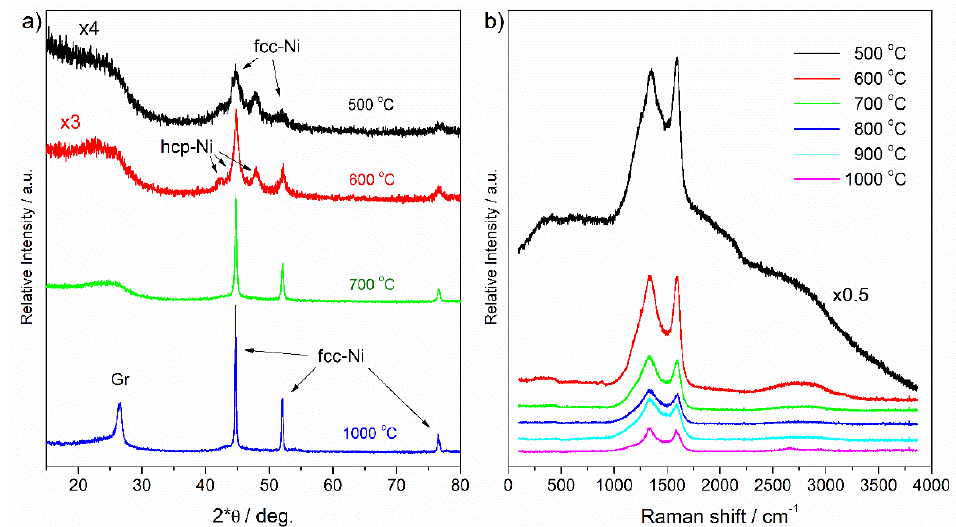
Figure 1. ( a ) Powder X-ray diffractogram of selected Ni-NP/C microspheres carbonized for 8 h (see Table 1), ( b ) Raman spectra of Ni-NP/C microspheres carbonized for 4 h (carbonization temperatures are indicated in Figures). Table 1. Crystalline phase composition relative to the total nickel content of the carbonized resin.